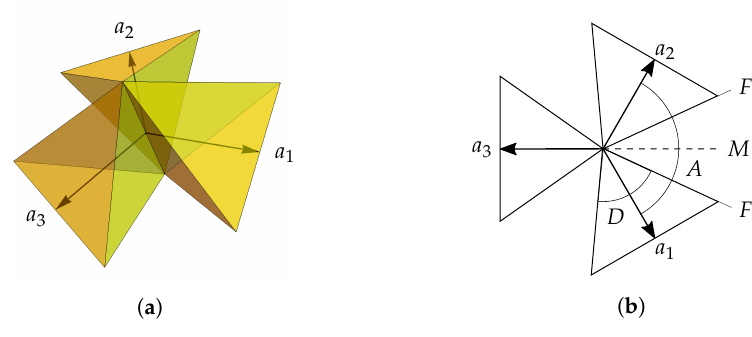
Figure A1. ( a ) Edge-sharing group of three tetrahedra, including the a i from the centre of the shared edge out toward the centres of the respective opposite edges. (The unit vectors a i are not to scale—the distance between the centres of two opposite edges is not necessarily a unit length.) ( b ) Overhead view showing the face planes F and F (cid:48) that will be rotated into coincidence by the transformation (curve or twist) defined by a 1 and a 2 . D is the dihedral angle of a tetrahedron and A is the angle between their centres (i.e., between adjacent a i